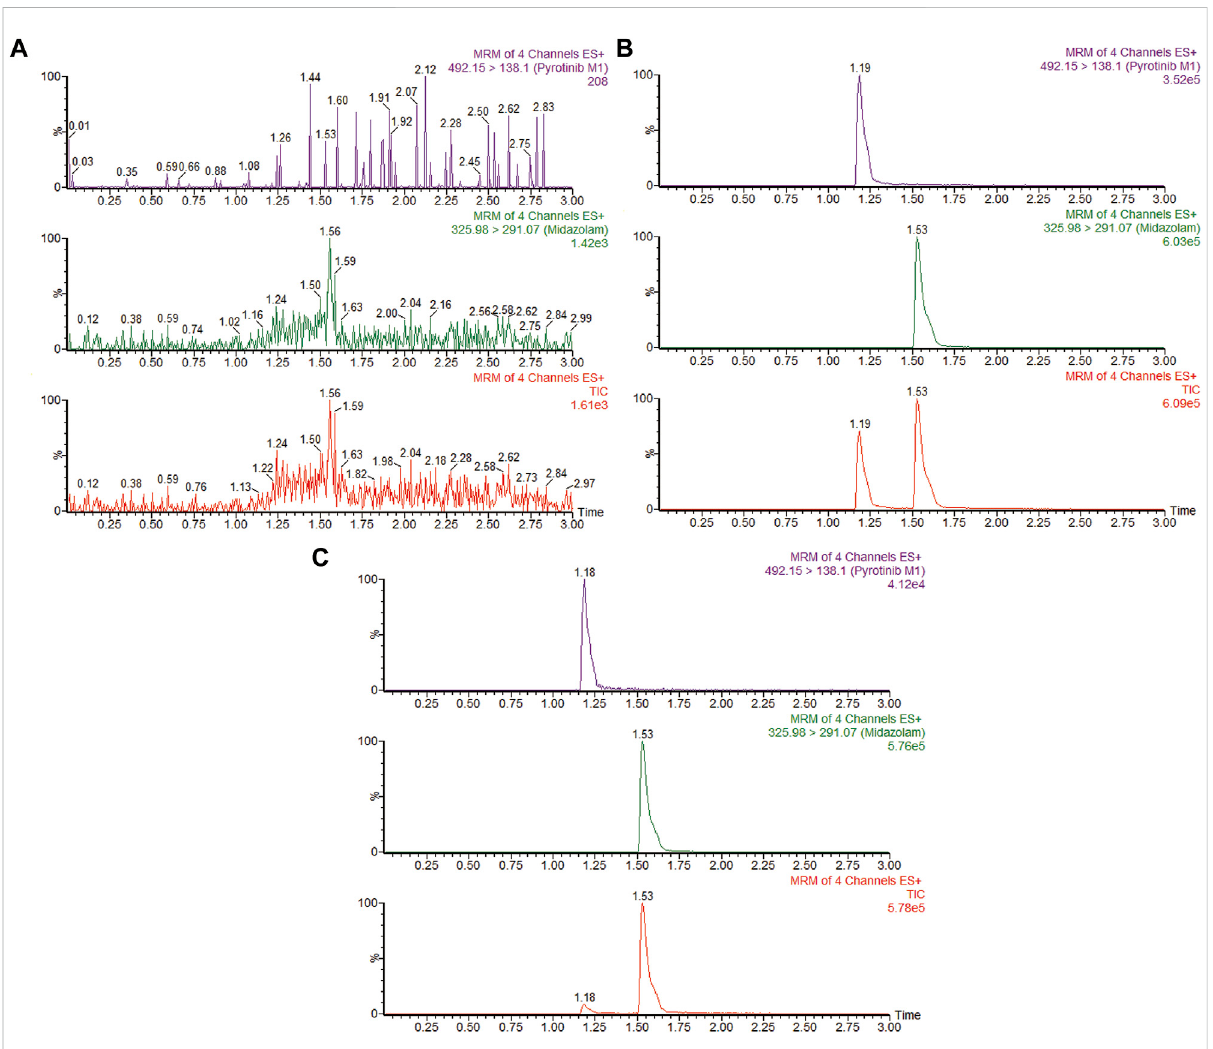
FIGURE 2 MRM chromatograms of pyrotinib M1 and IS in RLMs. (A) Blank RLMs (B) Denatured RLMs with pyrotinib M1 and IS, and (C) Incubation